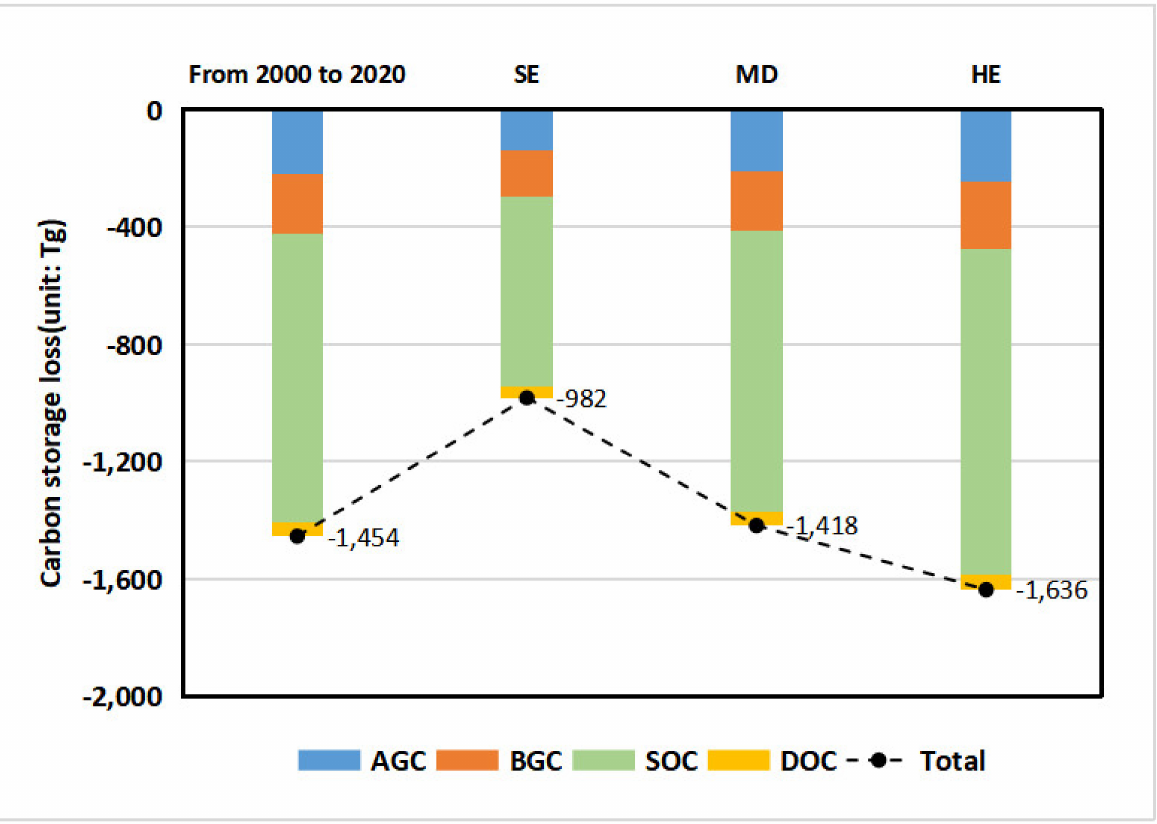
Figure 7. Carbon storage loss in YRD under different